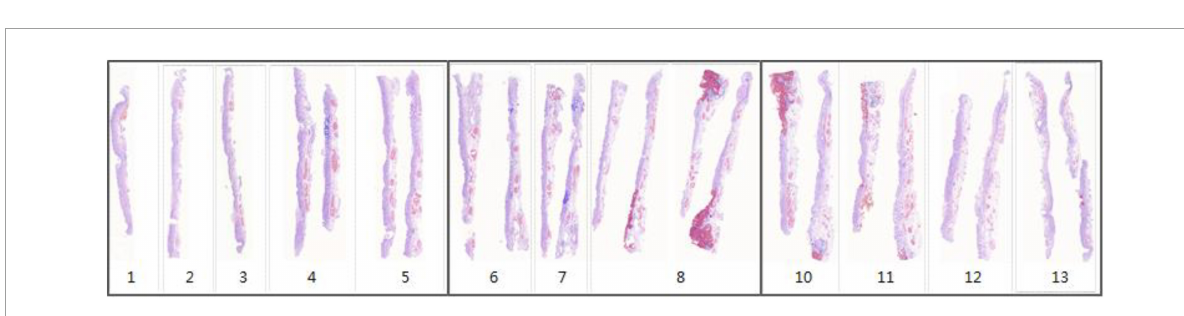
TABLE 2 The segmentation performance of our model and